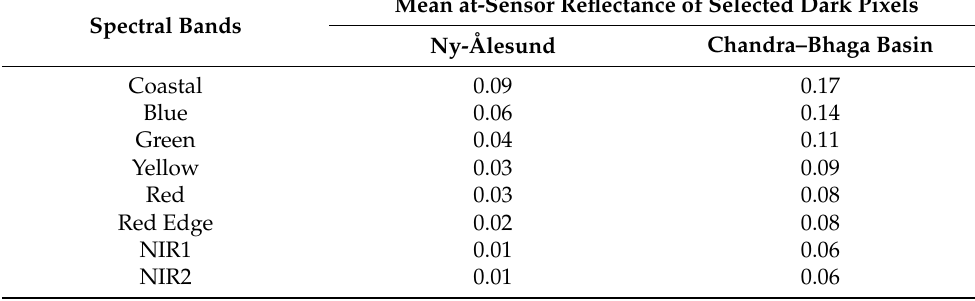
Table 4. Spectral-band-wise at-sensor reflectance values of selected dark pixels for input into DOS correction module in ENVI